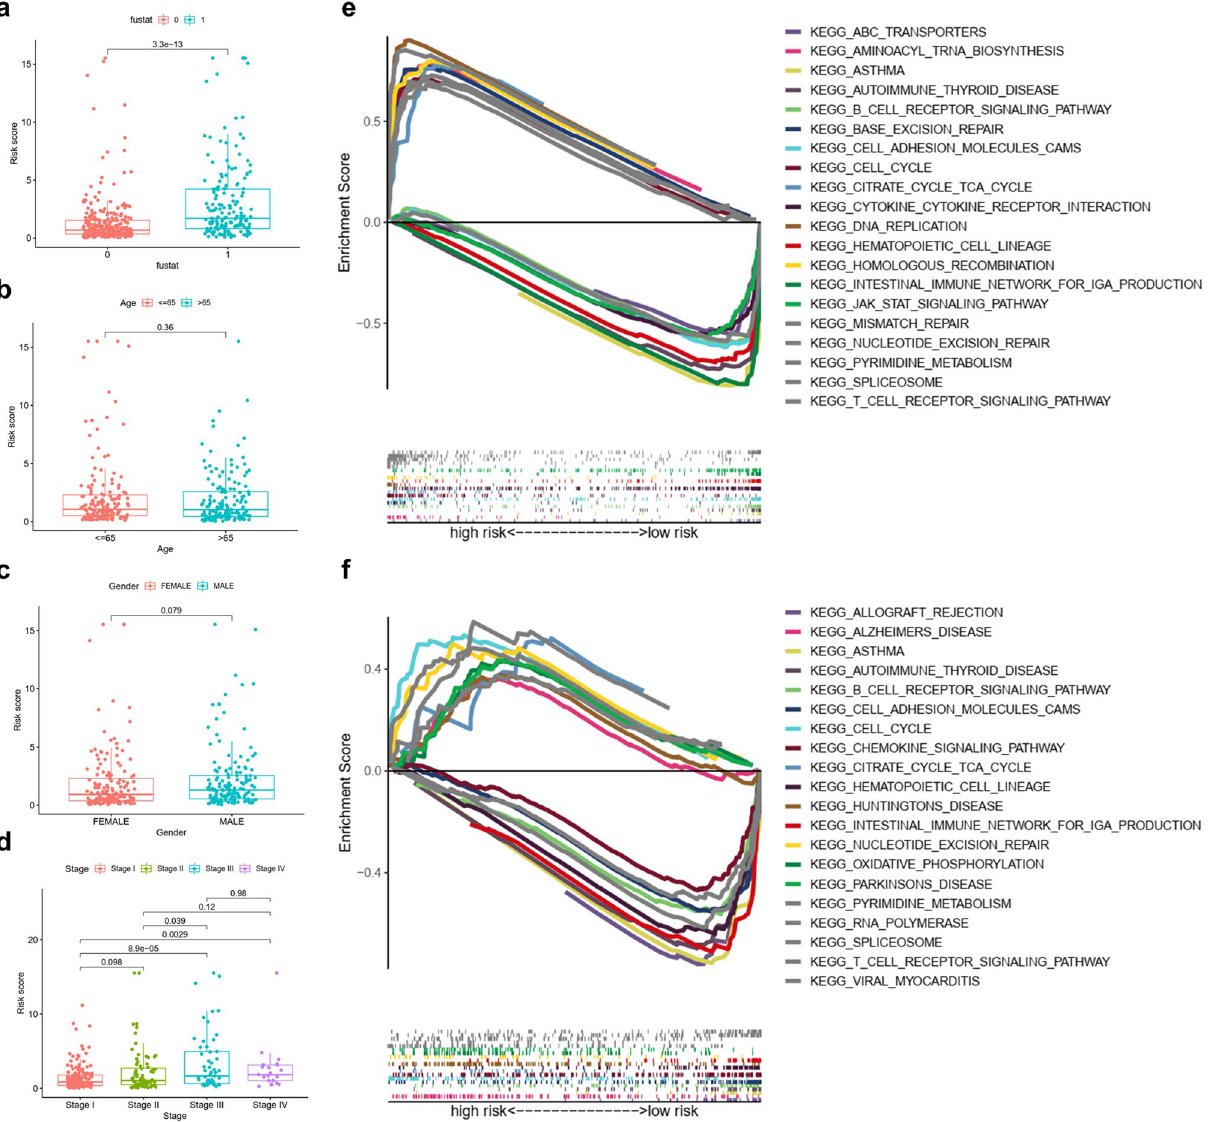
Figure 4. Correlation analysis between RS and survival status ( a ) (“fustat” mean “survival state”, 0 = alive, 1 = dead), age ( b ), gender ( c ), and stage ( d ) in the TCGA cohort. GSEA analysis and immune characteristics in the HRG and LRG. ( e ) The TCGA-LUAD cohort. ( f ) The GEO-GSE42127